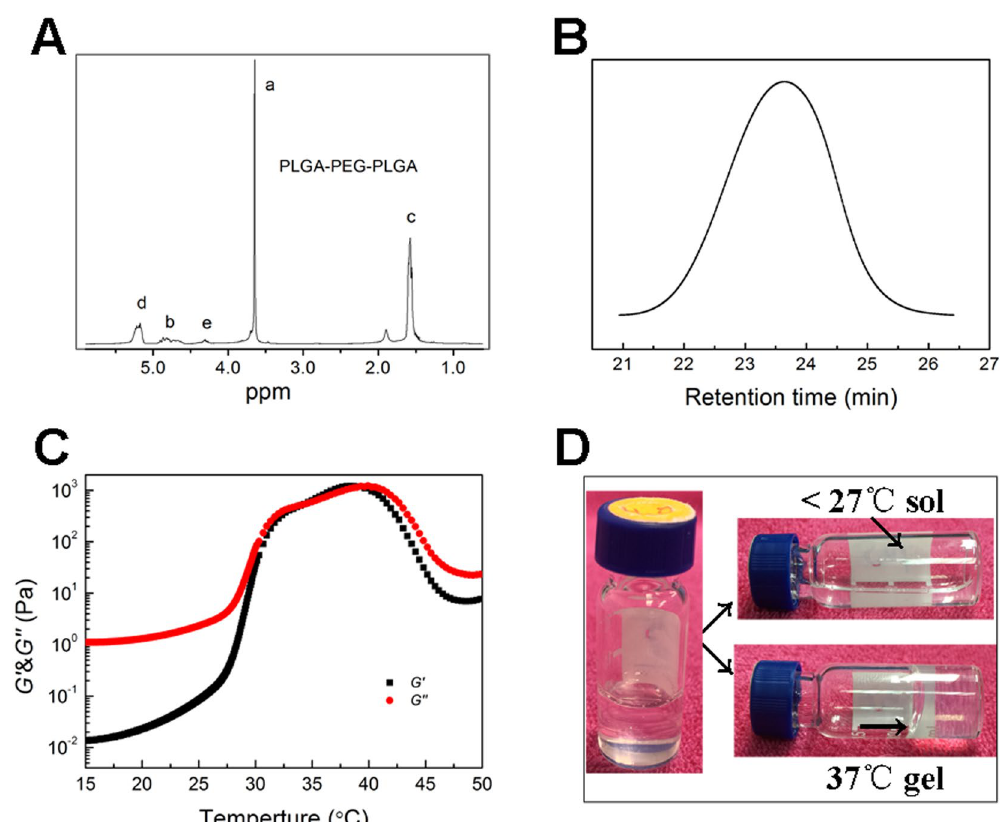
Figure 2. ( A ) 1 H NMR specturm of the PLGA-PEG-PLGA copolymer, ( B ). GPC analysis of the